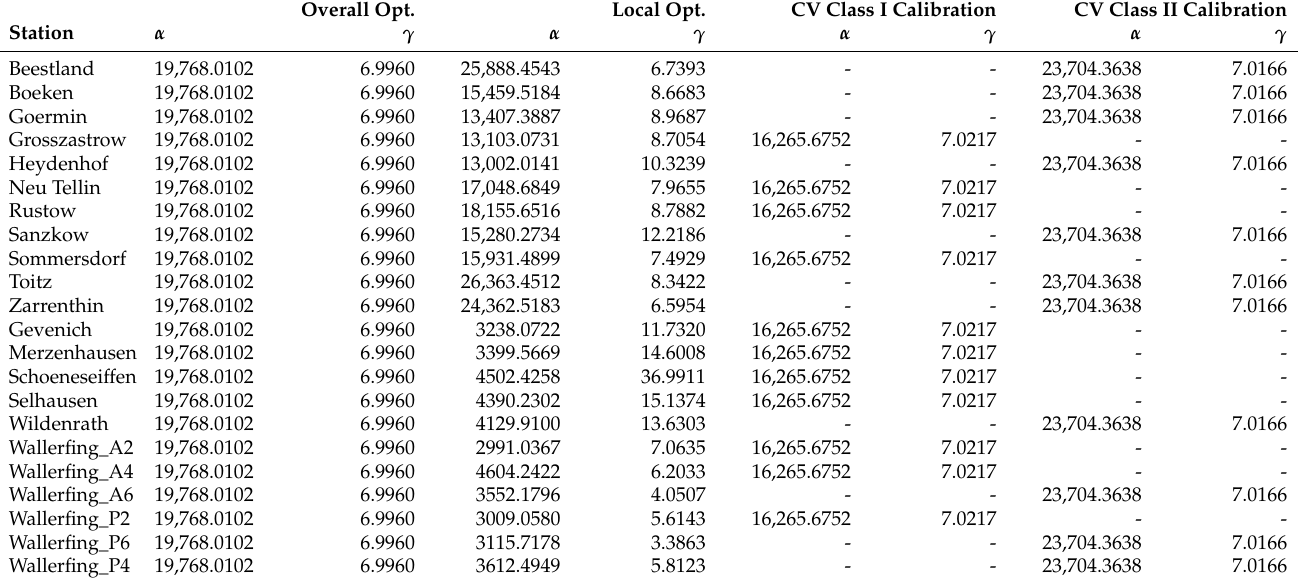
Table A2. Values of variables α and γ for overall and individual (local) optimization and variable values in the respective cross validation class